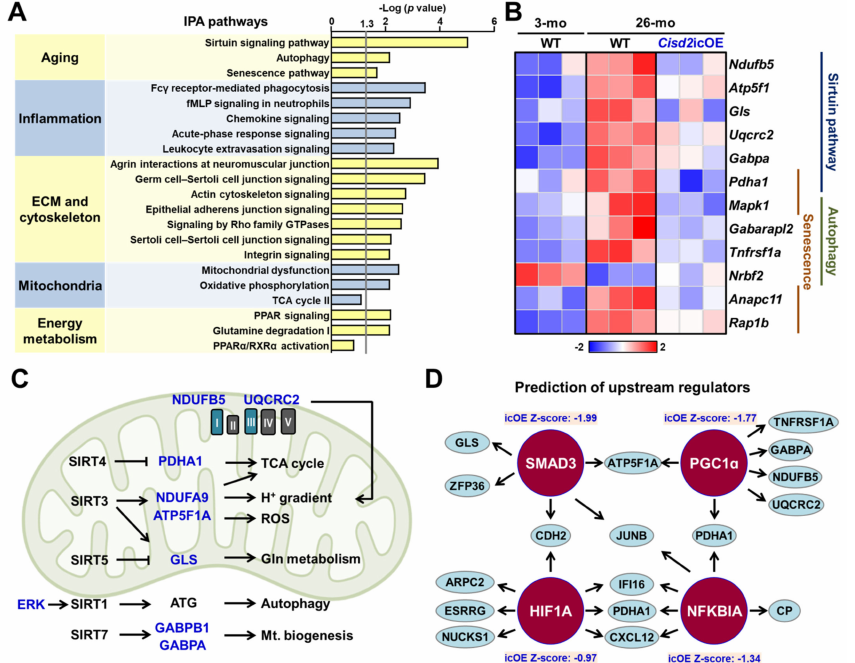
Figure 5. Analyses of the biological functions and pathways of the DEGs reverted by cardiac-specific Cisd2 overexpression. ( A ) Ingenuity pathway analysis (IPA) of the DEGs. ( B ) Heatmaps representing the Cisd2 -reverted DEGs (26-mo Cisd2 icOE vs. 26-mo WT mice, p < 0.05) related to the sirtuin, autophagy, and senescence pathways. ( C ) The diagram illustrates the relationships between the SIRT family genes and their related biological functions and the Cisd2 -reverted genes. The significant genes reverted by Cisd2 are highlighted with blue color ( p < 0.05). ( D ) The upstream regulators obtained by IPA upstream regulator analysis. The figure was created with